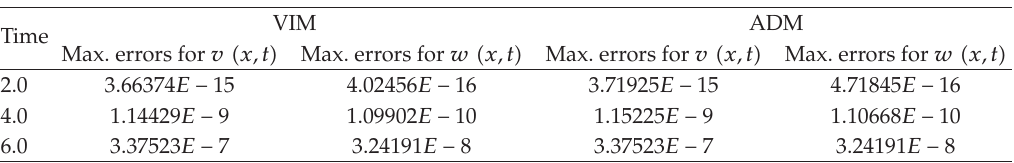
Table 3: The maximum errors of our suggested methods VIM and